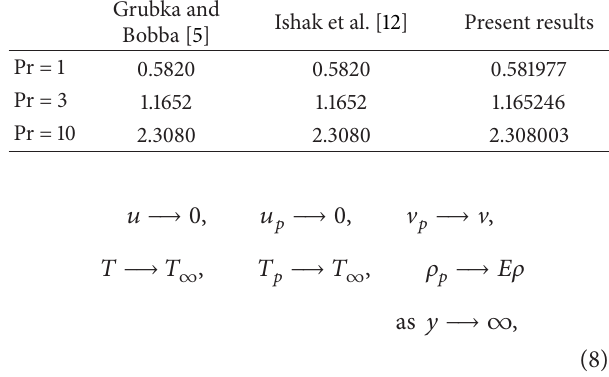
Table 2: Comparison of −𝜃 󸀠 (0) values for various values of Pr when 𝑀 = Gr = 𝑁 = 𝑆 = 0 . Grubka and Bobba